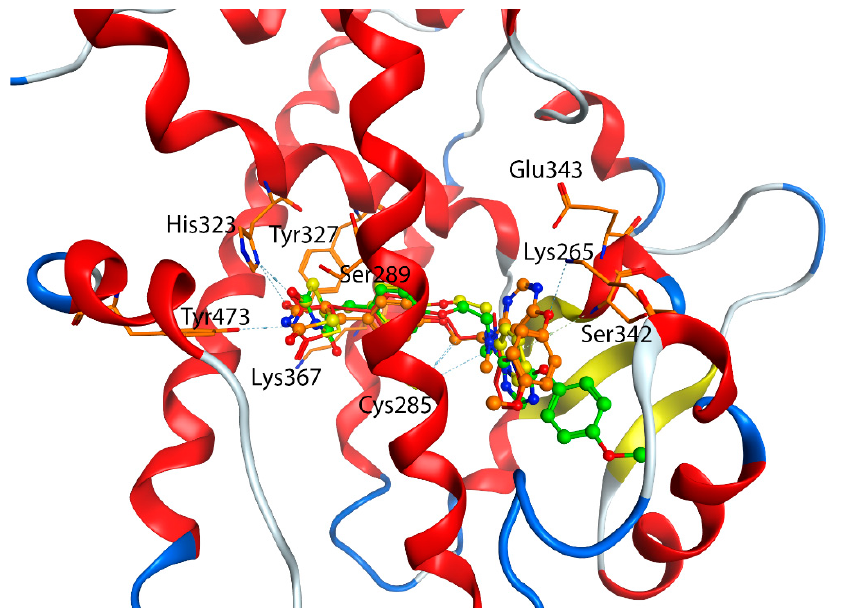
Figure 6. Interactions between PPAR γ agonists at the orthosteric site and allosteric site based on the Induced-Fit Docking. Yellow: Rosiglitazone from the orthosteric site; Red: Rosiglitazone from the allosteric site; Green: Lobeglitazone from the orthosteric site; Orange: Lobeglitazone from the allosteric site.